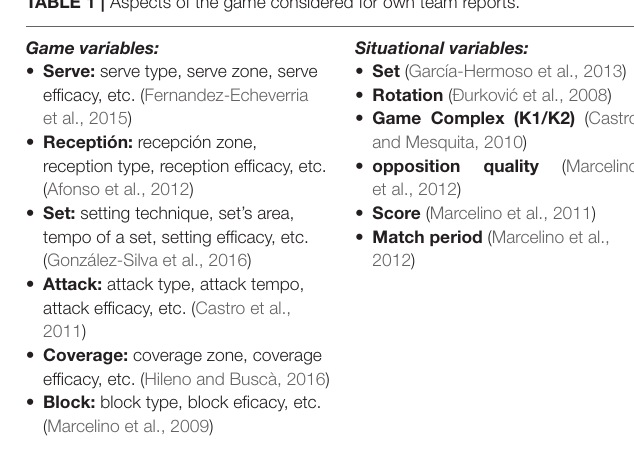
TABLE 1 | Aspects of the game considered for own team reports.